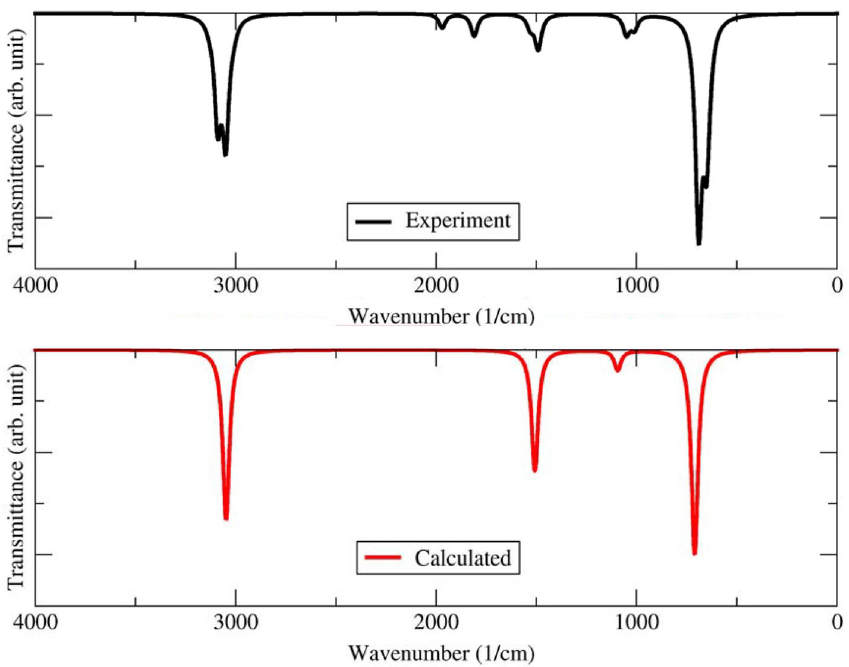
Figure 2. Infrared spectra of Benzene in the gas phase from experimental data (black) and calculation results